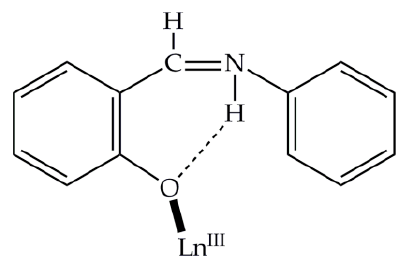
Scheme 3. The coordination mode of the zwitterionic ligand salanH in the mononuclear complexes of the present work. The coordination bond is drawn in bold.